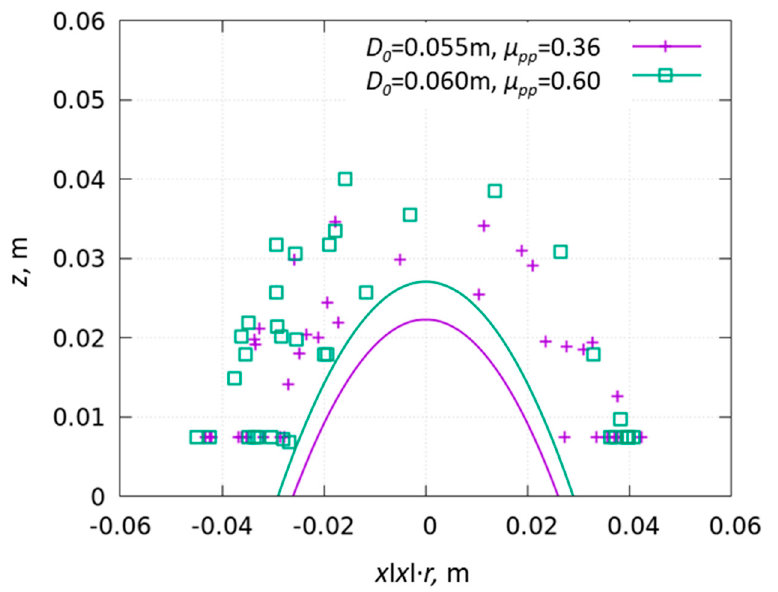
Figure 12. Distribution of centers of spheres forming the dome at flow arrest and parabola fitted into points on particle surface being closest to empty space created by stable arch.